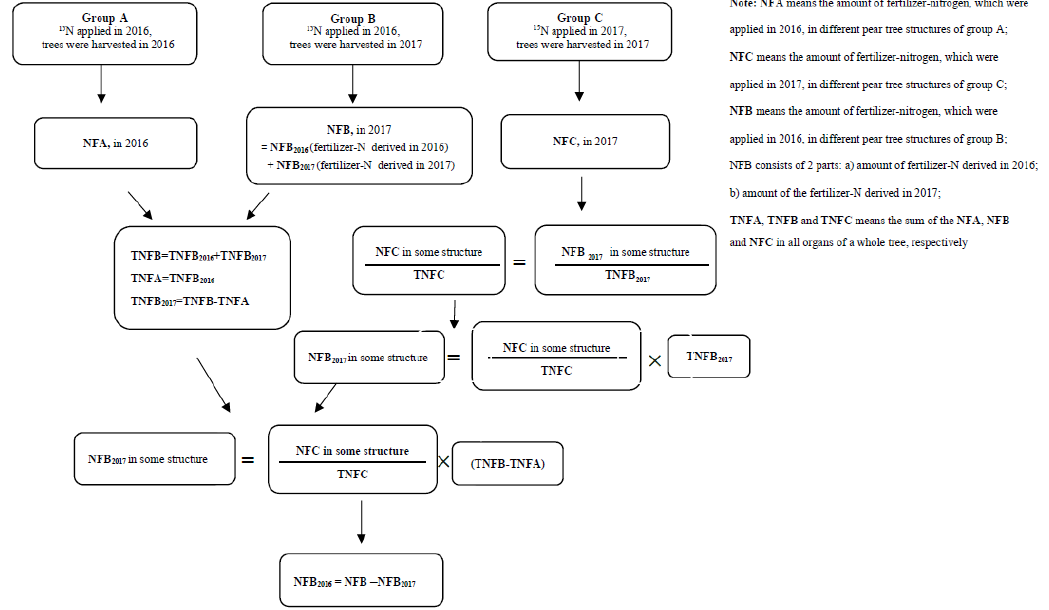
Figure 1. The calculation method of the amount of fertilizer-N, which was taken up in 2016, in each structure in 2017.